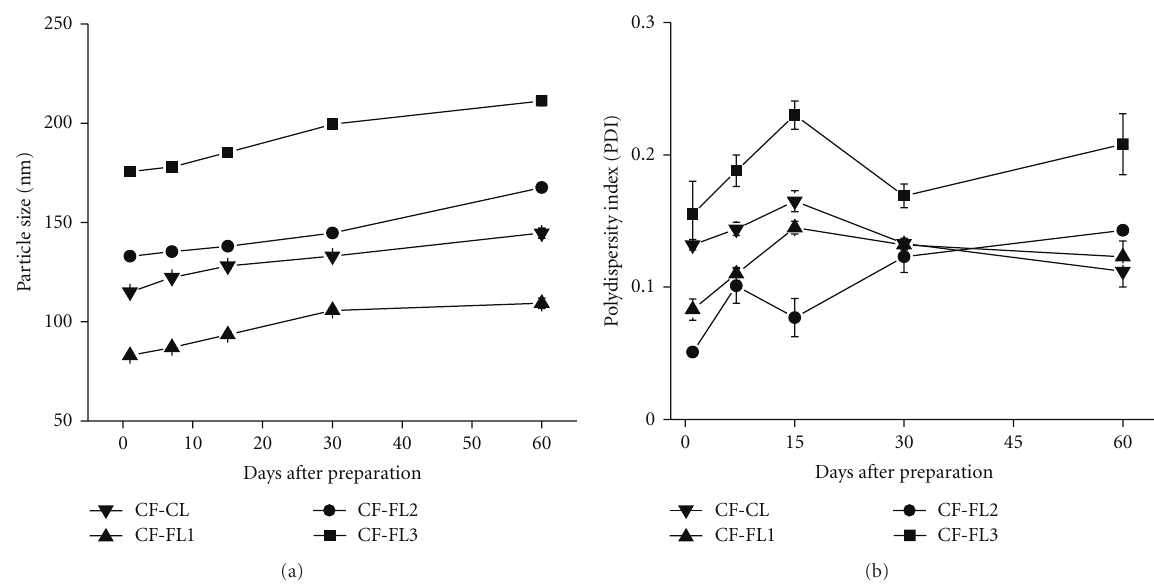
Figure 2: Stability study of CF-loaded liposomal dispersions stored at 4 ◦ C over 2months duration. (a) Change of particle size (z-average), (b) change of the polydispersity index